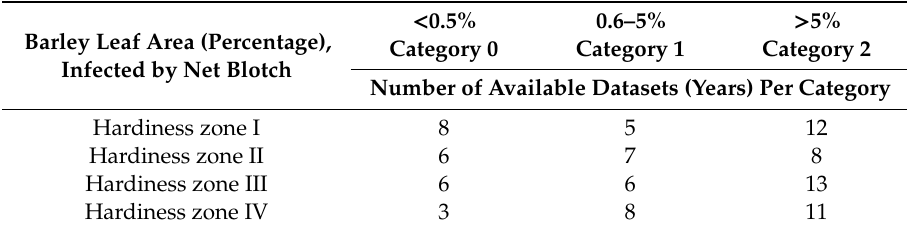
Table 1. General information about the data selected for